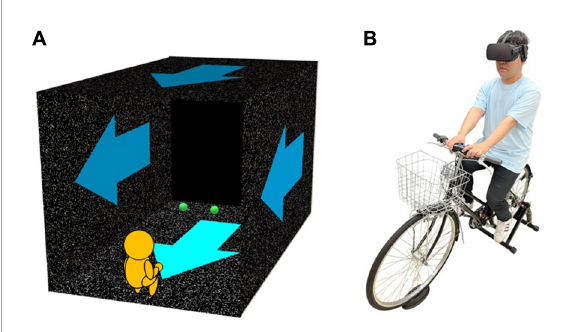
FIGURE1 A pattern diagram of the virtual reality environment presented using a head-mounted display (A) and the bike (B) . (A) In the virtual environment, the body was not presented. Participants observed stimuli at the center of a rectangular parallel-piped tunnel. The tunnel was painted with white random dots (density: 15%) on a black background. In the self-motion conditions with optical flow, the white dots moved toward the participants (i.e., blue arrow) and induced forward self-motion perception. In the self-motion conditions without optical flow, the dots remained stationary. In each trial, the fixation point was first presented at 3 m ahead of the participants along the midsagittal plane. When participants’ pressing a start button, the fixation point disappeared. One second later, a pair of green spheres (visual probes, the height of observer’s subjective shoulder) were presented as an aperture for 100 ms 3 m ahead of them. Their task was to judge whether they can pass through the aperture. (B) The bike was fixed using the fixed roller. Participants sat on the bike wearing the HMD. They pedaled it at a constant speed (18 or 72 rotations per minute) along with the guide sound, in the self-motion condition with pedaling. In the conditions without pedaling, they remained seated on the bike. The magnetic sensors were placed at the rear wheel of the bike and the rotation number of the rear wheel was recorded for manipulation